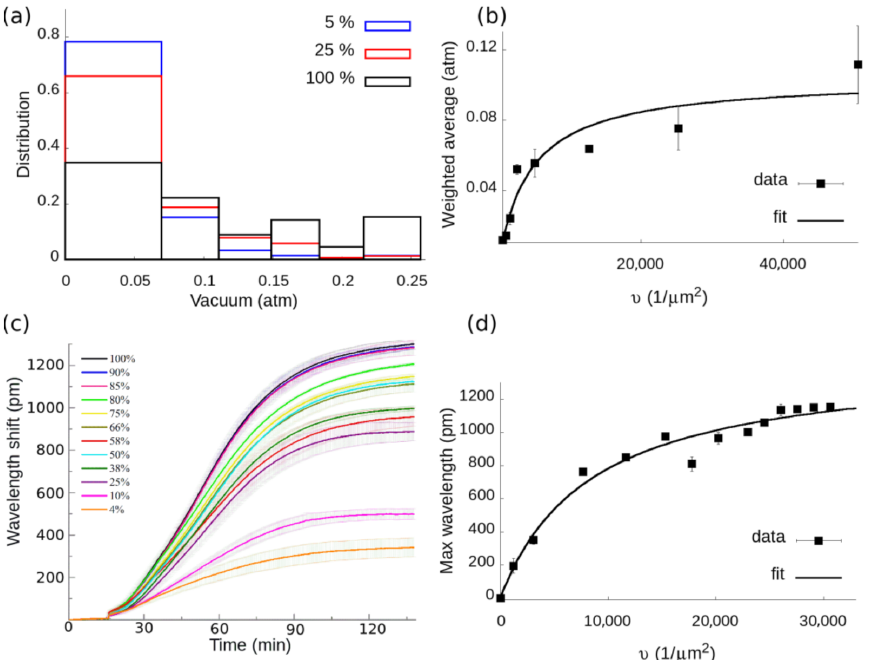
Figure 3. ( a ): Histograms of cell detachment calculated from the detachment curves. The inset shows the PPR to PP percentage ratio ( Q ) of the surfaces on which the cells were seeded. As Q increases, the distributions shift to the right, towards higher detachment pressures. ( b ) The fit of Equation (6) on the weighted average of all detachment histograms. From the fit, the two-dimensional dissociation constant can be determined. Error bars show the standard error of 3 measurements. ( c ) Adhesion kinetics of cell populations measured by RWG optical biosensor. Surface coatings with different PPR to PP ratio were used to create different RGD densities. The maximum wavelength shift was fitted for each curve according to Equation (8), and the resulting values were plotted against the RGD density in ( d ). Here, Equation (6) is fitted on the maximal wavelength values to determine the two-dimensional dissociation constant. Error bars show the standard error of three separate